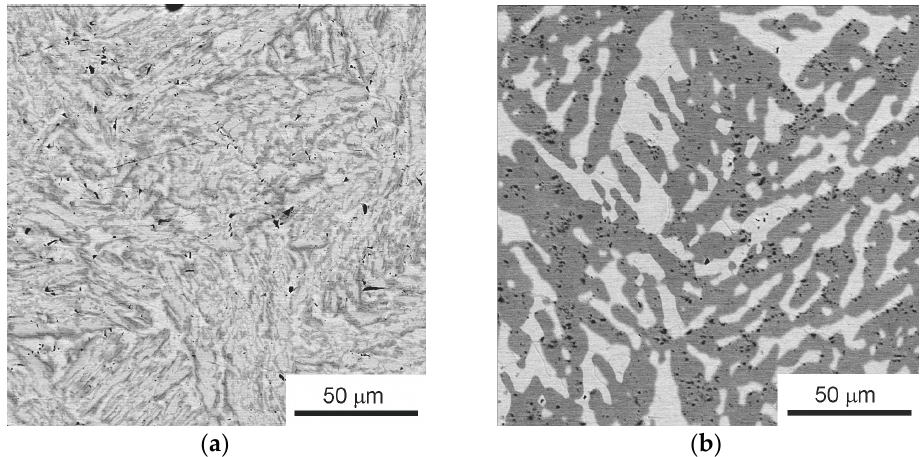
Figure 9. SEM images of the microstructure of the TiZrHfMoCrCo alloy ( a ) the as-cast sample subjected to HPT, ( b ) HPT plus additional annealing at 1000 °C 96 h.